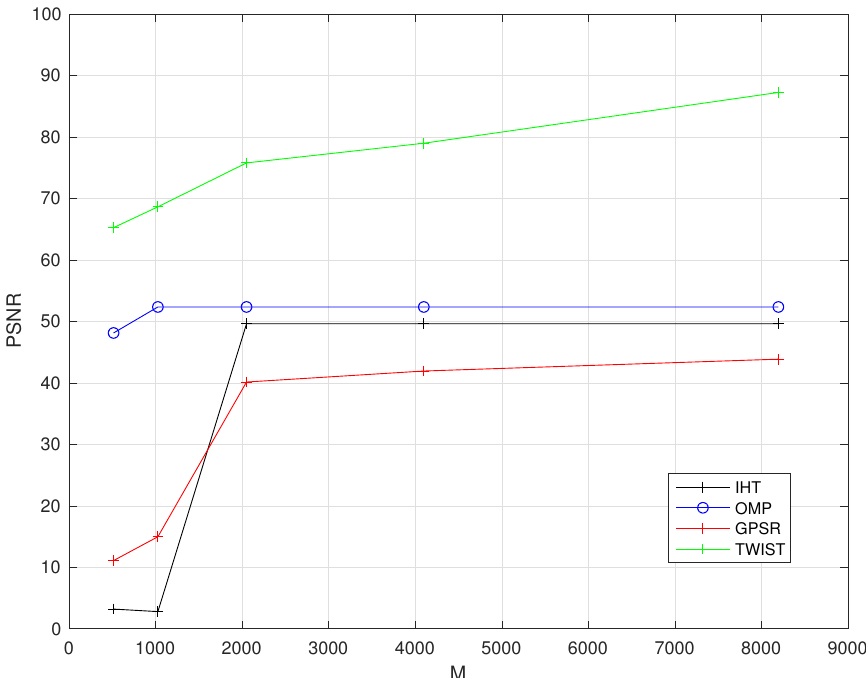
Figure 4. Reconstruction algorithms evaluation. LoRa symbols were created using encoded data. As previously stated, preamble and synchronization chirp symbols are generated; in our case, 10 preamble symbols (up- chirps) and 2 synchronizations (down-chirps) were modulated before the start of the